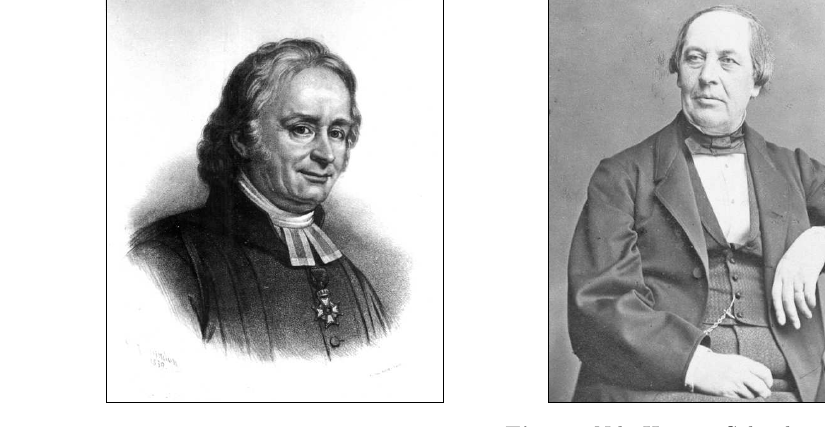
Fig. 5. Nils Haquin Selander 1804{1870. Image: Centre for History of Science { The Royal Swedish Academy of Sciences.